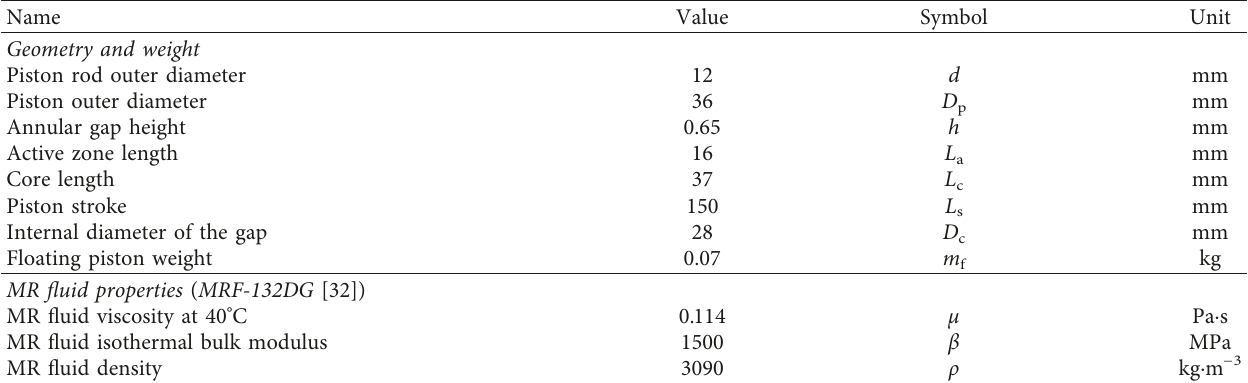
Figure 2: Virgin and hysteresis magnetization curves. (a) Hysteresis curve of 11SMn30. (b) Static curve of 11SMn30. (c) Static curve of MRF 132-DG [32]. Table 1: MR damper dimensions and material